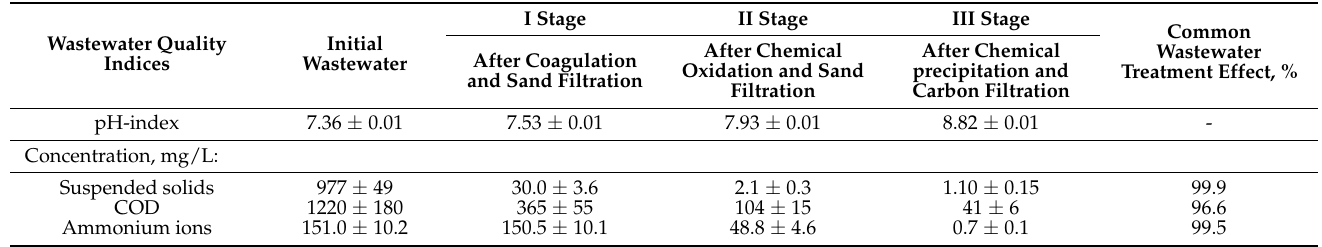
Table 5. Research results for physicochemical methods of wastewater treatment (2020).